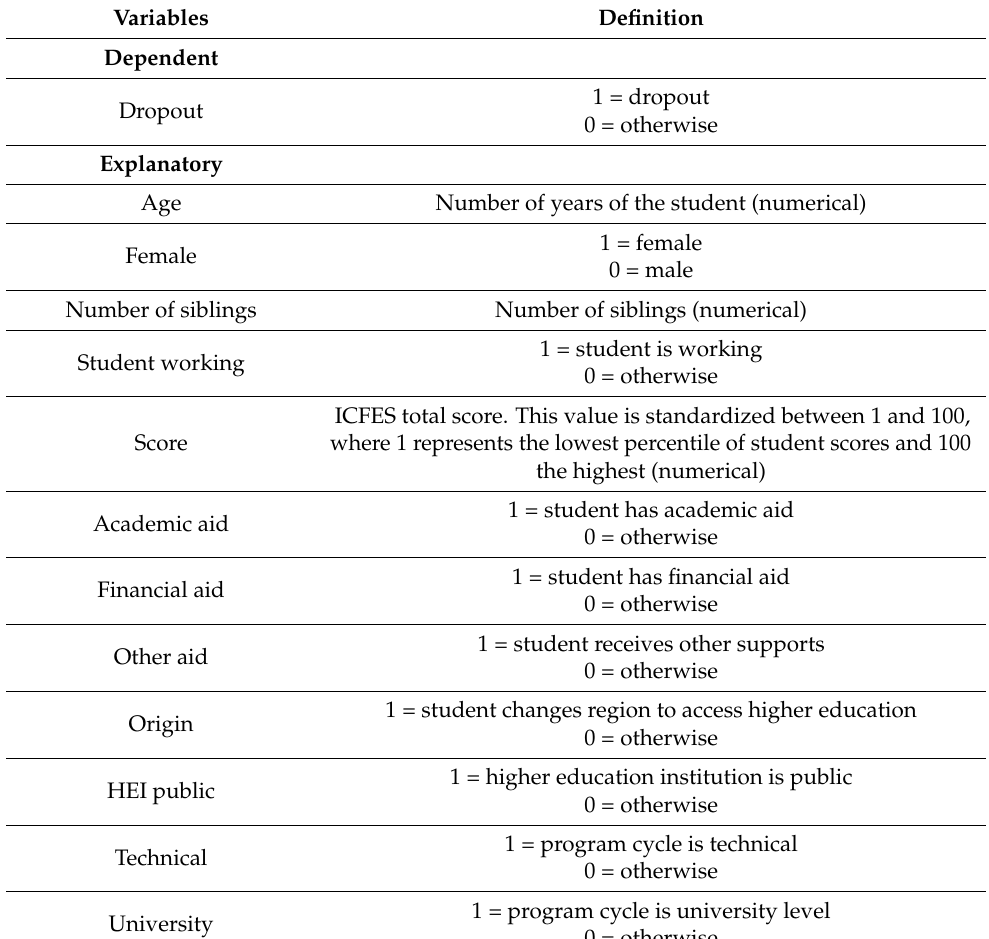
Table 3. Definition of variables used in the models.